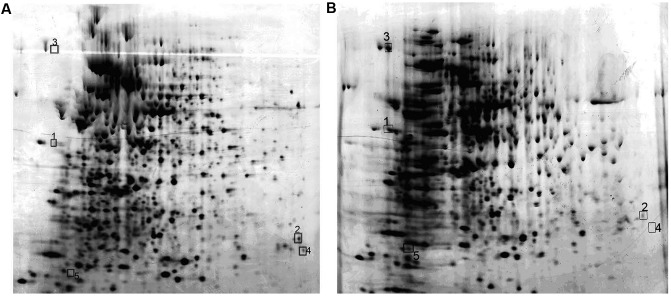
2-DE patterns of whole cell supernatant proteins from MSP and MSW strains that were conducted in the pH range of 4–7. The proteins from MSP
(A) and MSW
(B) were visualized by silver staining during the late log phase of bacterial growth. The spot numbers on the reverse image correspond to proteins identified by MALDI-TOF-MS, as listed in Table 3. The data are representative of two independent experiments.